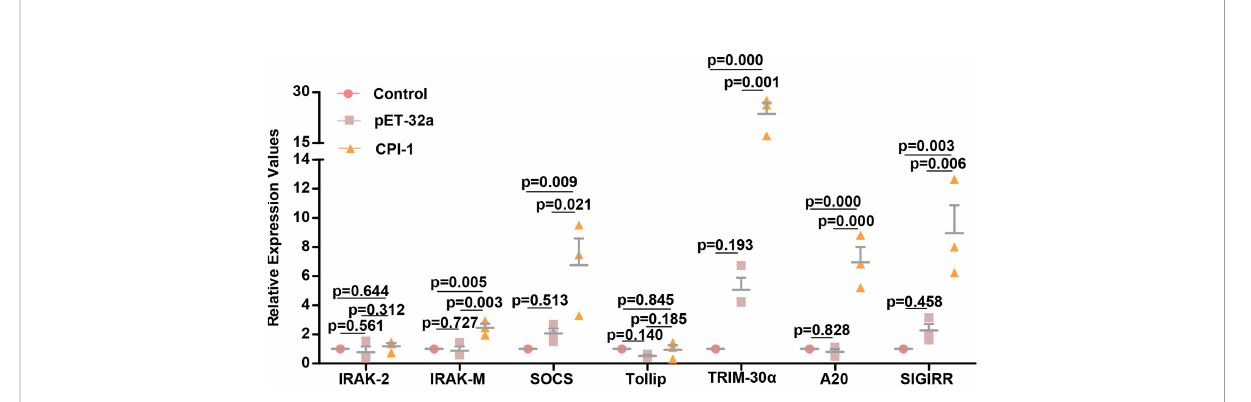
FIGURE 8 qPCR analysis of the relative expression of negative regulators of the TLR signaling pathway. The data are shown as the mean ± SD of 3 repetitions per